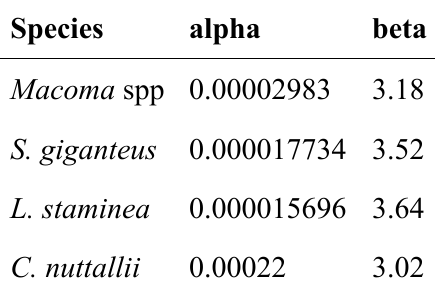
Table A1.1. Values by species for clam length-weight